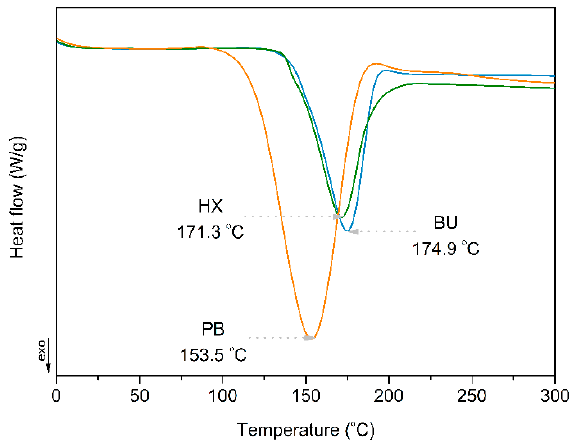
Figure 3. Heat flow vs. temperature for the thermal decomposition of BU, HX and PB peroxides.